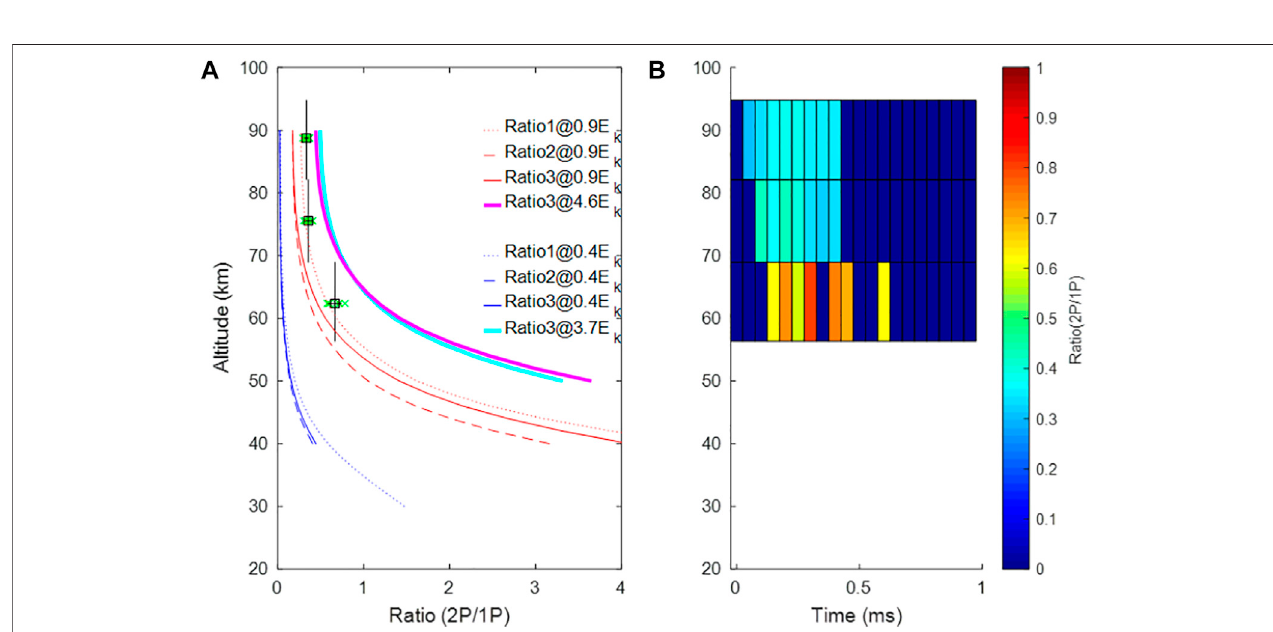
FIGURE 6 | The sprite halo event observed at 14:53:13.687 – 716 on October 3, 2005: (A) the AP-measured ratio 2P/1P with predicted emission ratios of Ratio 1 ( r CB ) , Ratio 2 ( R CB ) , and Ratio 3 ( R p CB ) at ambient electric fi elds of 0.4 E k and 0.9 E k . The thick cyan and magenta lines represent the predicted 2P/1P ratio in sprite streamersimulationswithstreamerheadelectric fi eldsof3.7E k and4.6E k underambientelectric fi eldsof0.4E k and0.9E k ,respectively.Thegreencrossesindicatethe datapointsofAP-measuredratios,whilethesquaresymbolsarethemeansoftheAP-measuredratios,andthehorizontalbarsaretheirstandarddeviations. (B) the diagram of AP-measured ratios indicated by colors in altitudes and